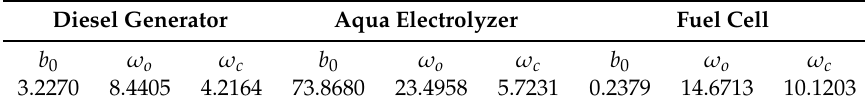
Table 4. The parameters of ILADRC controller used for simulation.